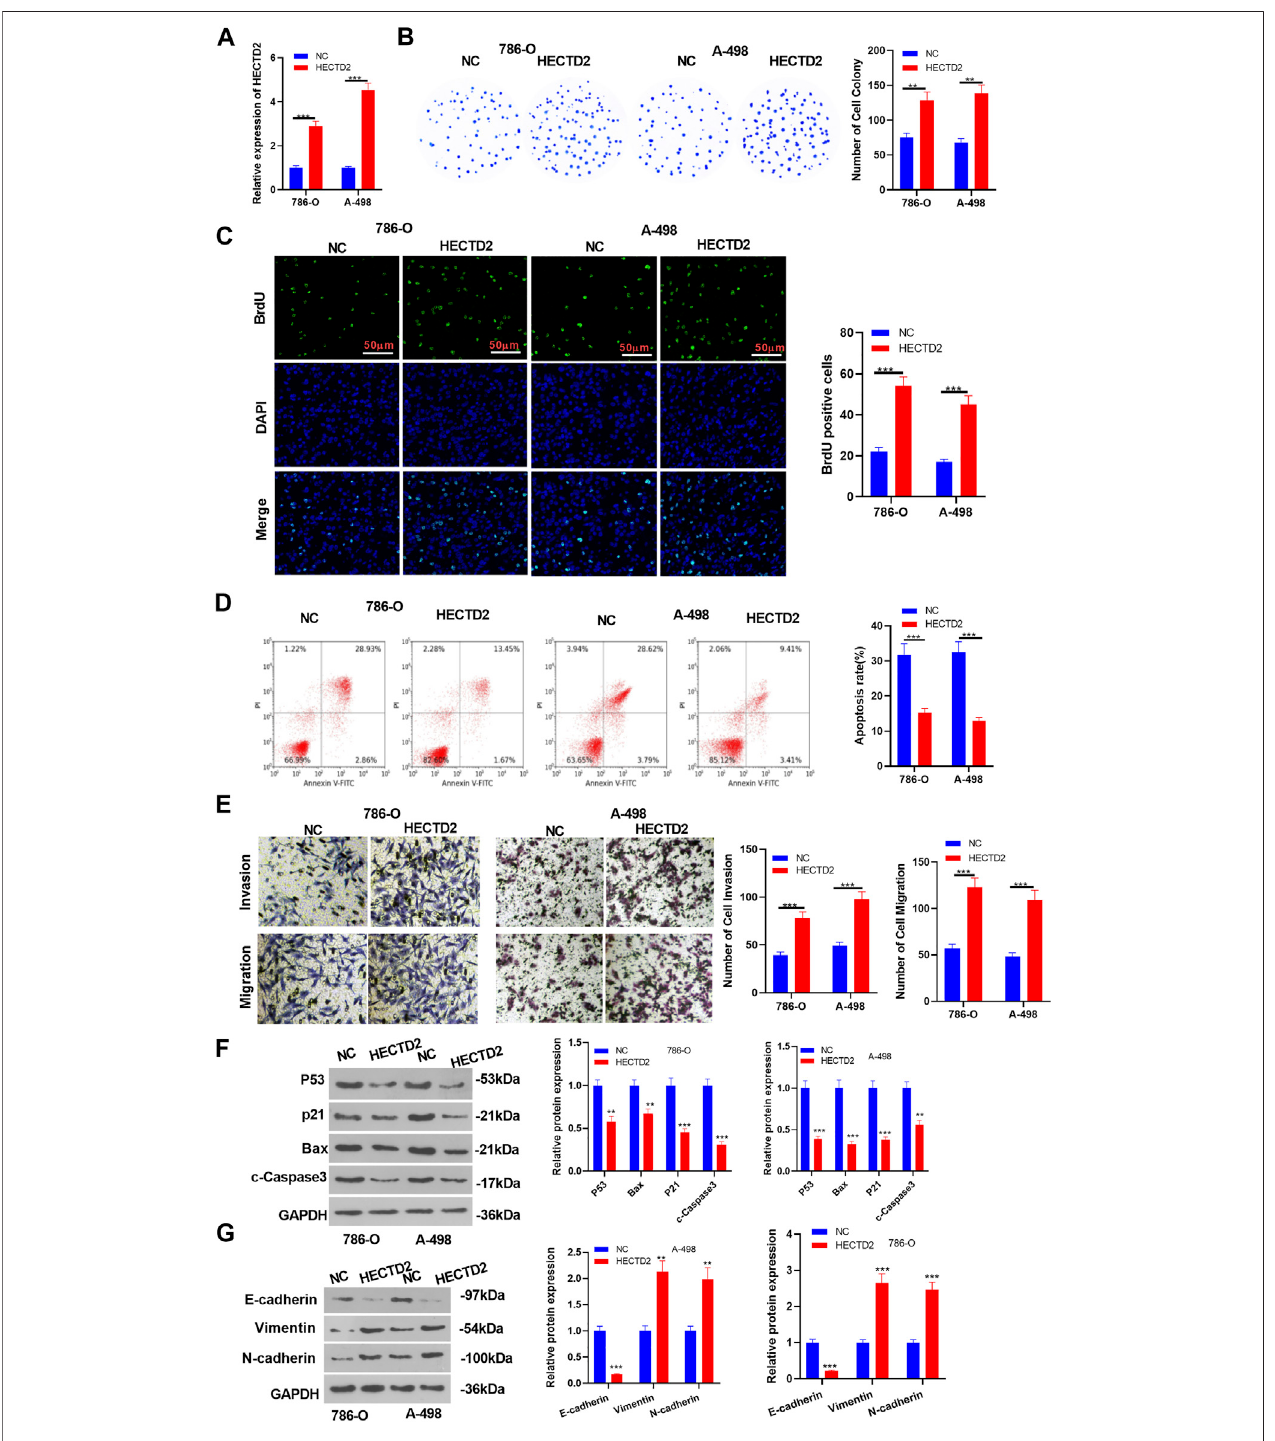
FIGURE2| EffectofHECTD2overexpressiononthemalignantphenotypeofRCC.OverexpressionmodelsofHECTD2wereconstructed in786-OandA-498 cell lines. (A) : RT-qPCR was implemented to testify the HECTD2 expression. (B – D) : RCC cell proliferation and apoptosis were determined by the colony formation experiment, BrdUassayand fl owcytometry,respectively. (E) RCCcellmigrationandinvasionwereassessed byTranswellassay. (F,G) :WBwasconducted toexamine the expression of P53, Bax, p21, c-Caspase3, E-cadherin, Vimentin, and N-cadherin. ** p < 0.01, *** p < 0.001 vs. NC group. N (cid:2) 3. Scale bar (cid:2) 50 μ m.